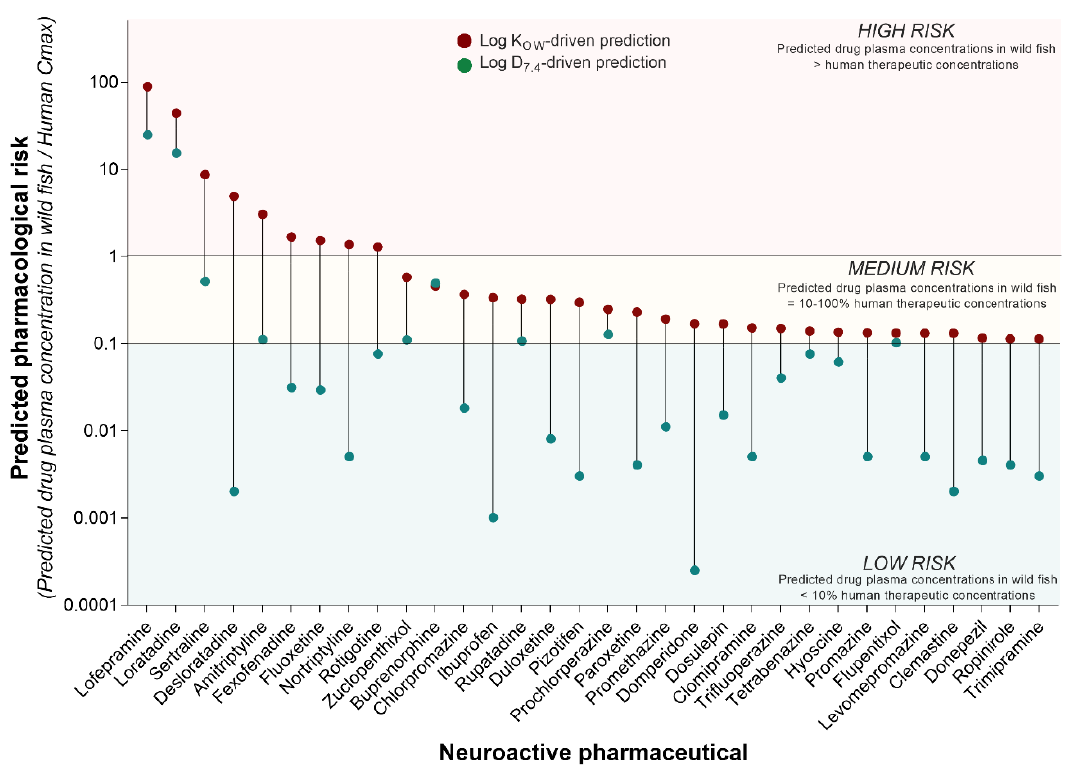
Figure 3. Predicted pharmacological risk to freshwater fish of neuroactive pharmaceuticals. The pharmacological risk of the 210 neuroactive pharmaceuticals identified in the present study was estimated by comparing the predicted concentrations of pharmaceuticals in fish plasma (F SS PC, ng/mL) and the human therapeutic plasma concentrations (HTPC) expressed as C max (ng/mL). Con- sidering the ratio F SS PC/HTPC, values ≥ 1 were classified as “ high risk, ” values between 1 and 0.1 as “ medium risk, ” and values < 0.1 as “ low risk. ” The figure displays all neuroactive pharma ceuticals predicted to have medium and high risk, based on the use of LogK OW for the prediction of drug uptake (red dots). To understand the impact of the use of different partitioning factors on the overall pharmaco- logical risk, the same prediction was also performed using Log D 7 . 4 (green dots).